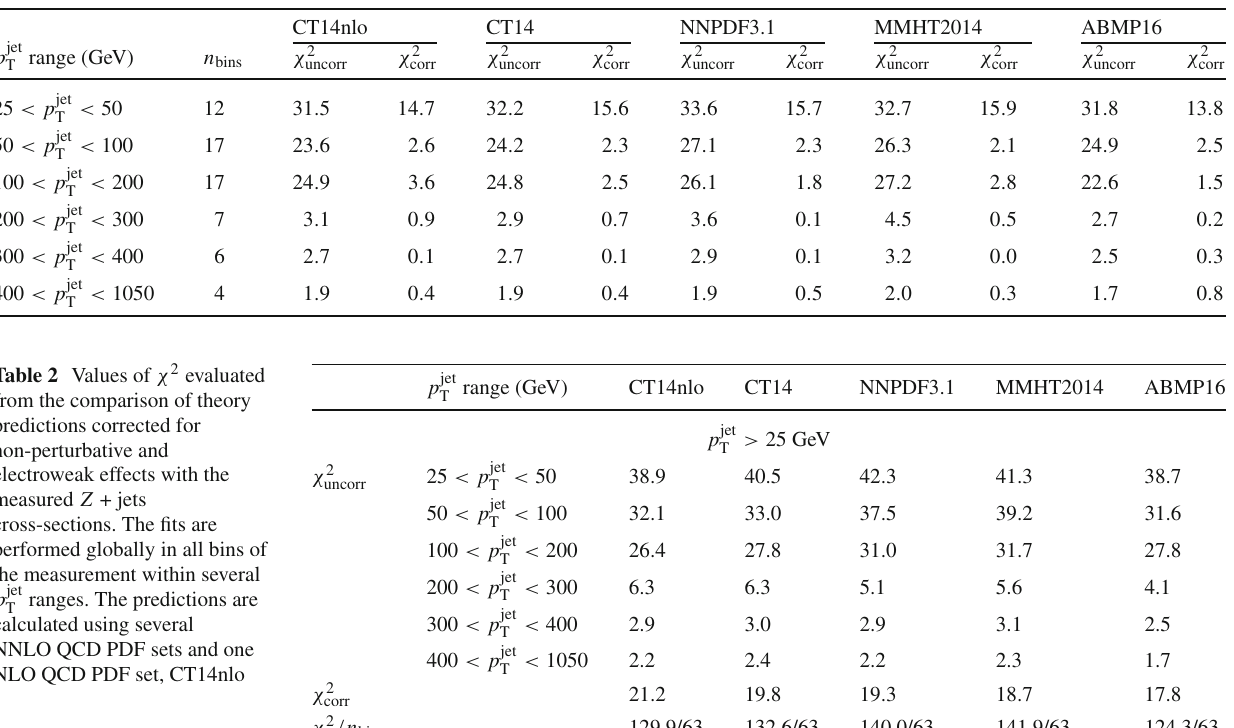
jet bin. The predic- T